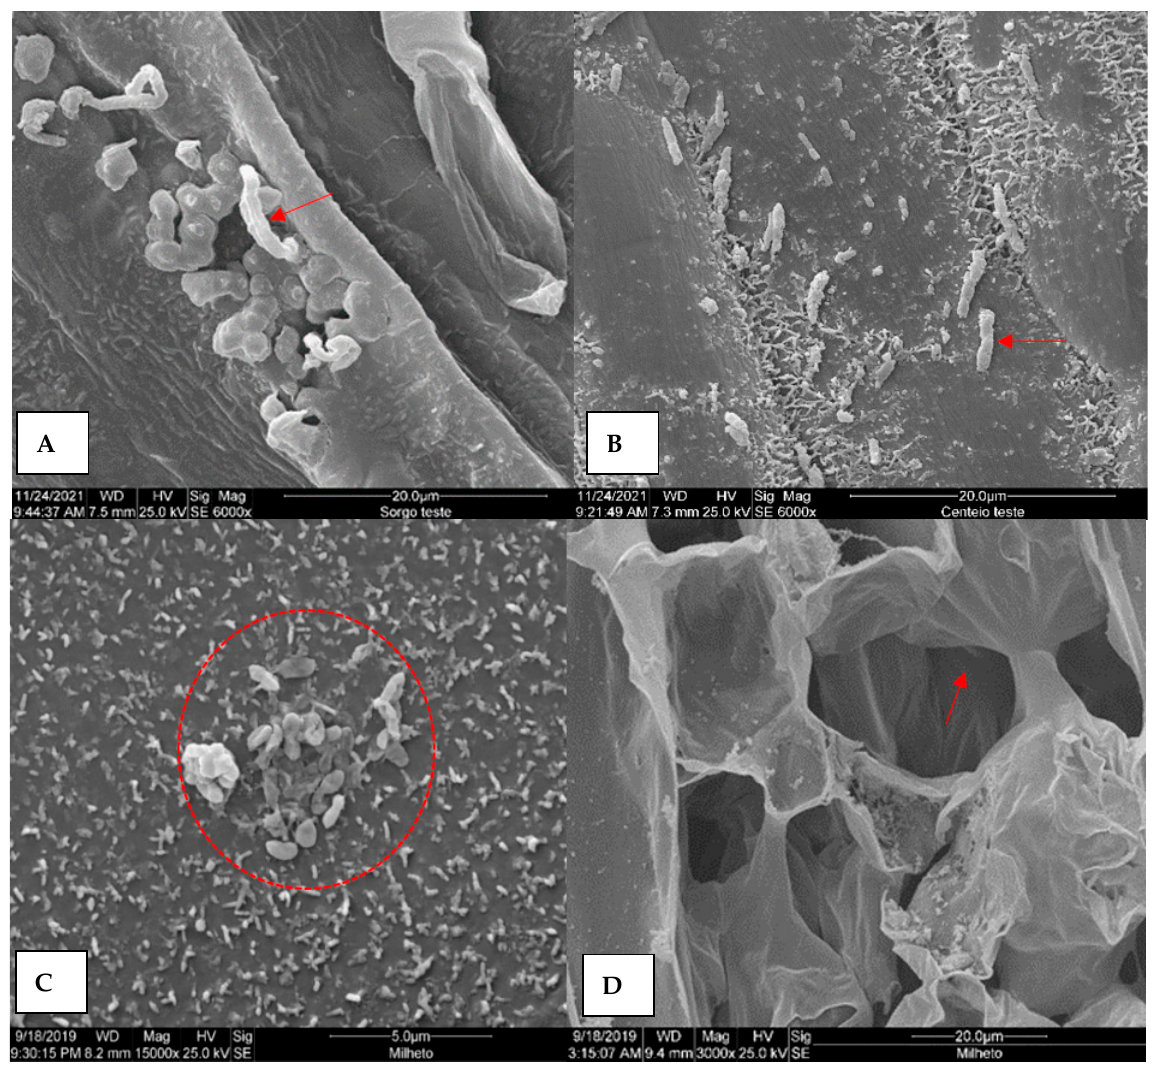
Figure 6. Scanning electron microscopy (SEM) of the surface of asymptomatic plants of sorghum cv. BRS 658, rye cv. IPR 89, and millet cv. IPR St. Tereza do Oeste at 15 days after inoculation (DAI) with Xanthomonas vasicola pv. vasculorum ( Xvv ). ( A ) Adaxial leaf surface of sorghum cv. BRS 658 with scattered Xvv cells in the epidermis (red arrow); ( B ) adaxial leaf surface of rye cv. IPR 89 with scattered Xvv cells in the epidermis (red arrow); ( C ) Xvv cell aggregates demonstrating altered morphology, indicating cell death on the adaxial surface of millet cv. IPR St. Tereza do Oeste (dashed circle); ( D ) fractures showing the internal structure of the leaf mesophyll, without evidence of bacterial colonization in millet cv. IPR St. Tereza do Oeste (red arrow).